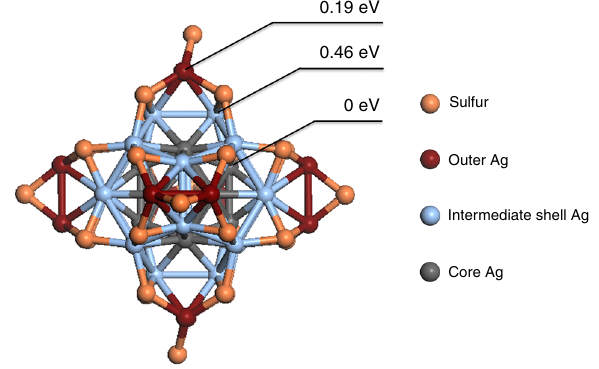
Fig. 7 Energy diagram of Au replacement sites in Ag 44 nanoclusters. The Ag atoms of [Ag 44 (SR) 30 ] 4 − (SR denotes thiolate ligand) are ordered into three general groups, the core Ag (gray), the intermediate shell Ag (light blue) and the outer shell Ag (purple). The sulfur (orange) atoms are shown, but the hydrocarbon tail and carboxylic ligand groups have been omitted for clarity. The relative energies for Au replacement on each of the three regions are labeled as motifs) at 0.19 eV higher in energy, and then the intermediate shell Ag (i.e., from Au 20 external core) at 0.46 eV higher in energy. This relative energetics of substitution agrees with the experimental formation of Ag@Au NCs by the SME mechanism.